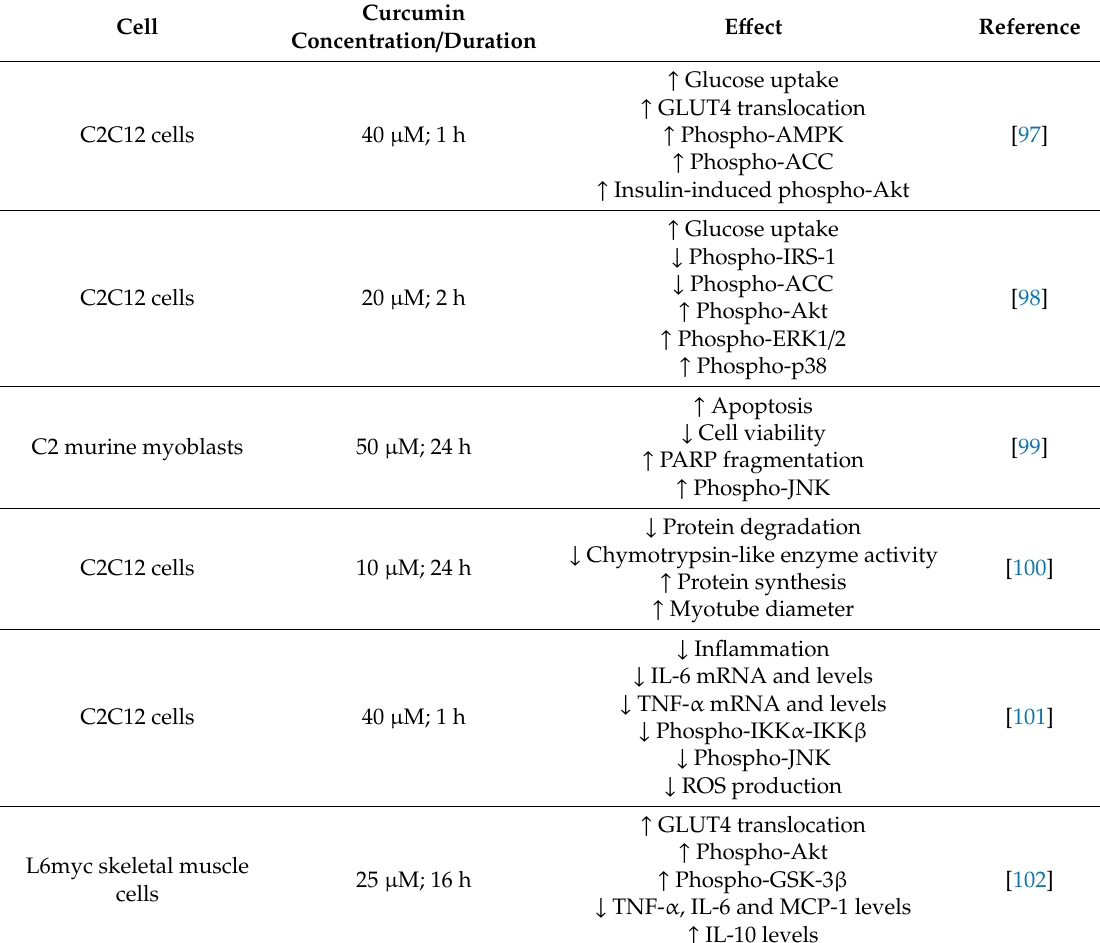
Table 3. E ff ects of curcumin: in vitro muscle cell